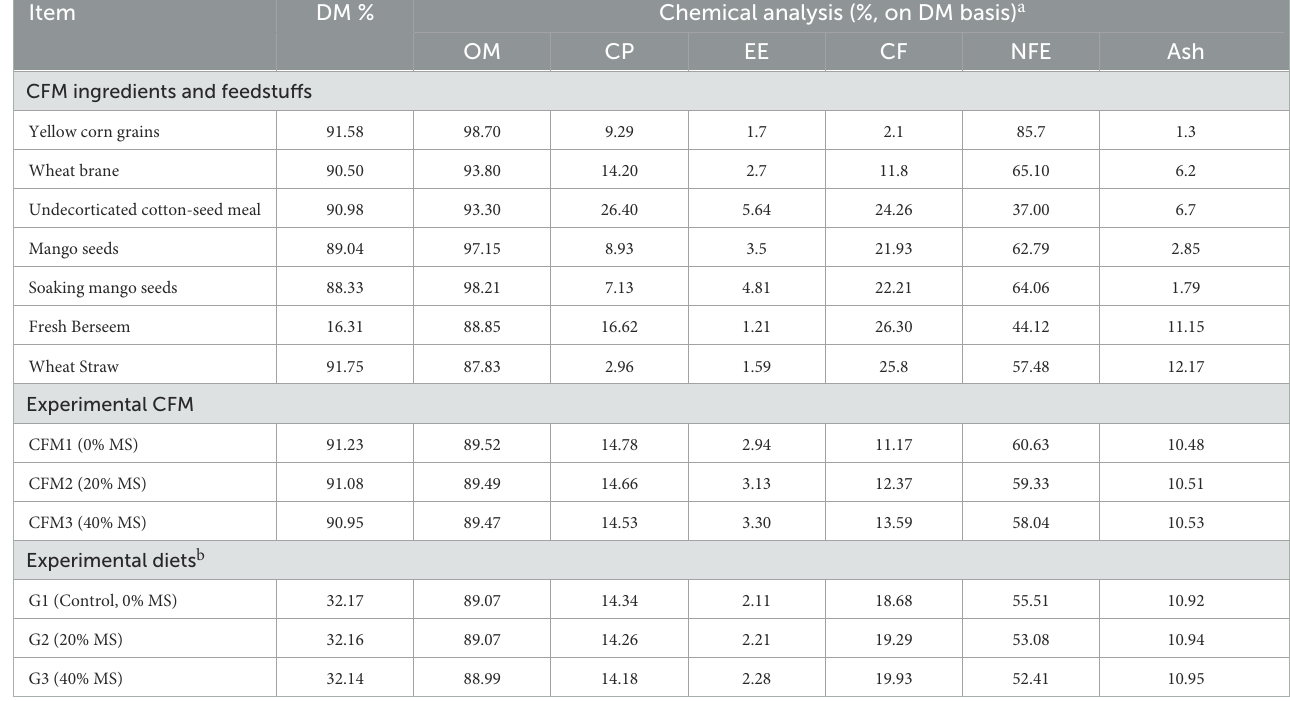
TABLE 2 Chemical analysis of CFM ingredients and feedstuffs, and CFM and the tested diets of experimental groups. Item DM %